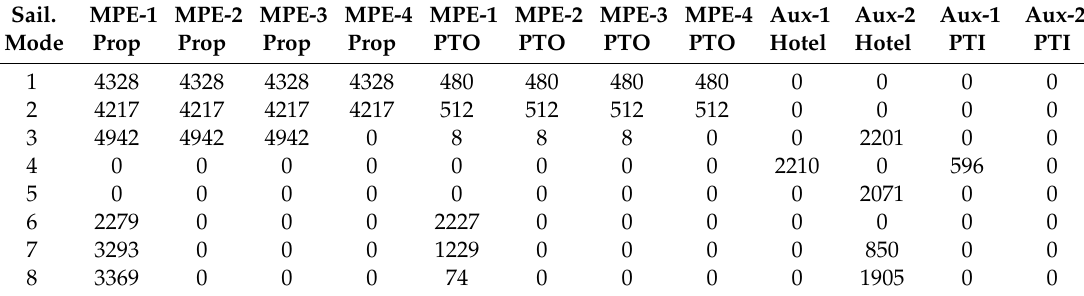
Table 10. Cruise ship: MINLP unit scheduling.